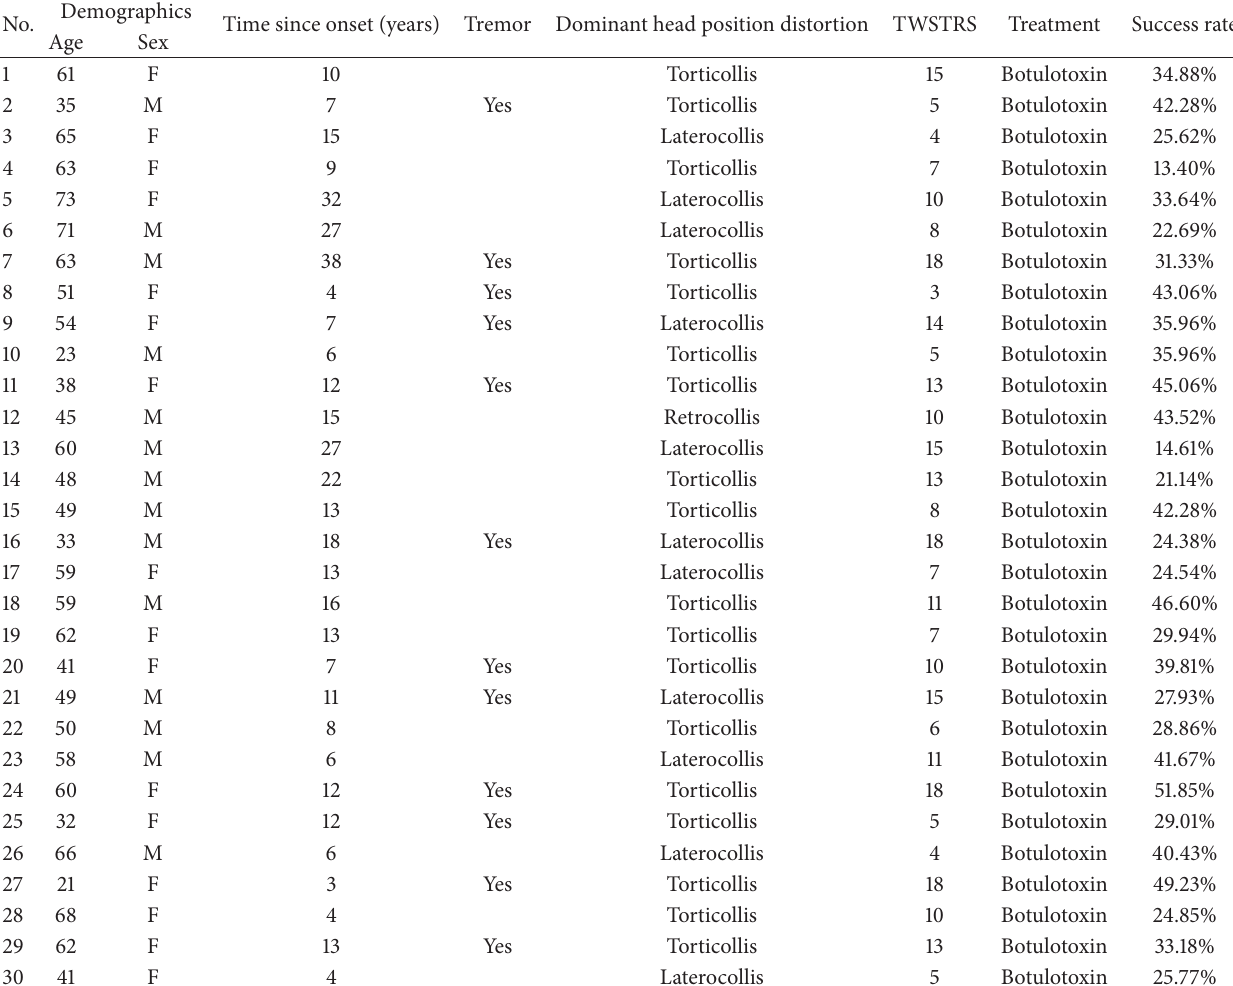
Table 1: Further information about the cervical dystonia